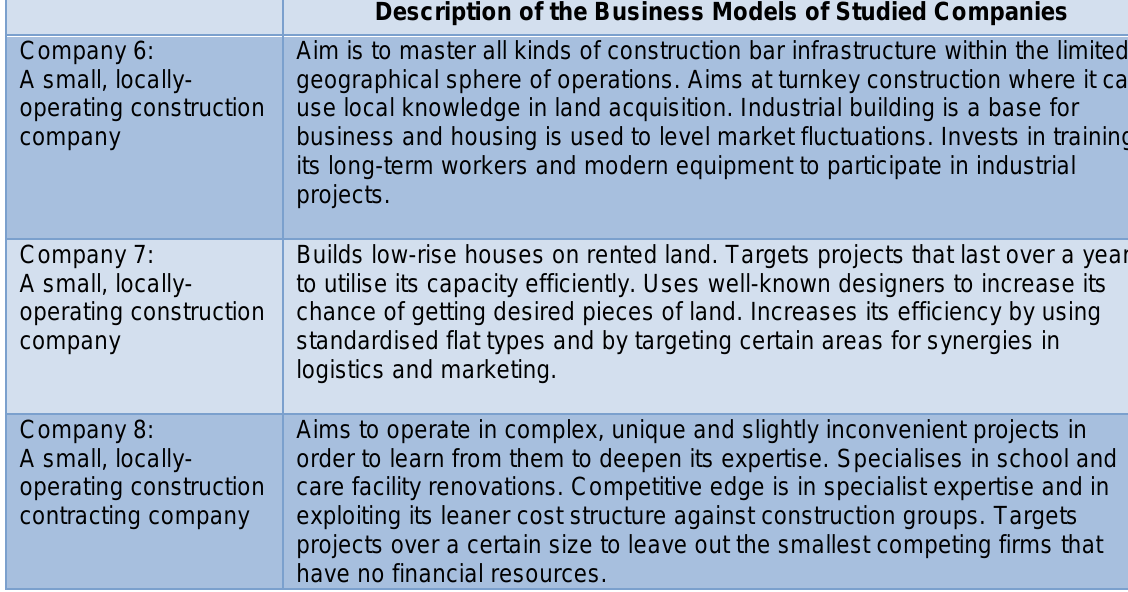
Table 1 Descriptions of the business models